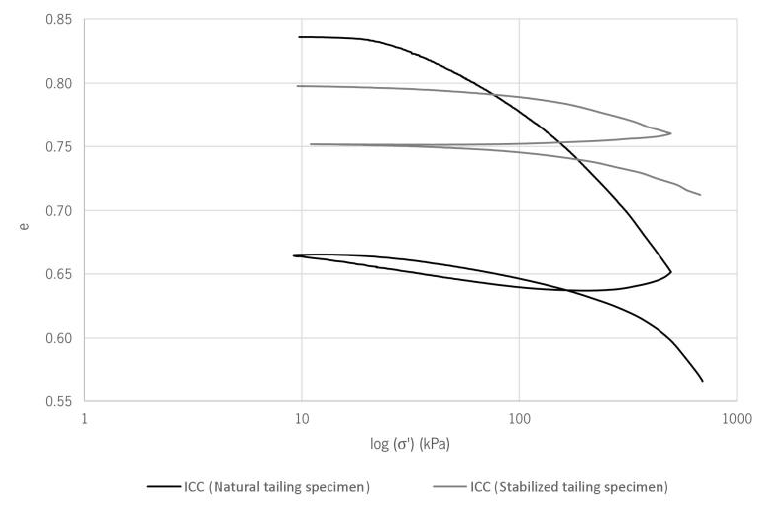
Figure 16. Isotropic consolidation curve of the mine tailing before and after stabilization.